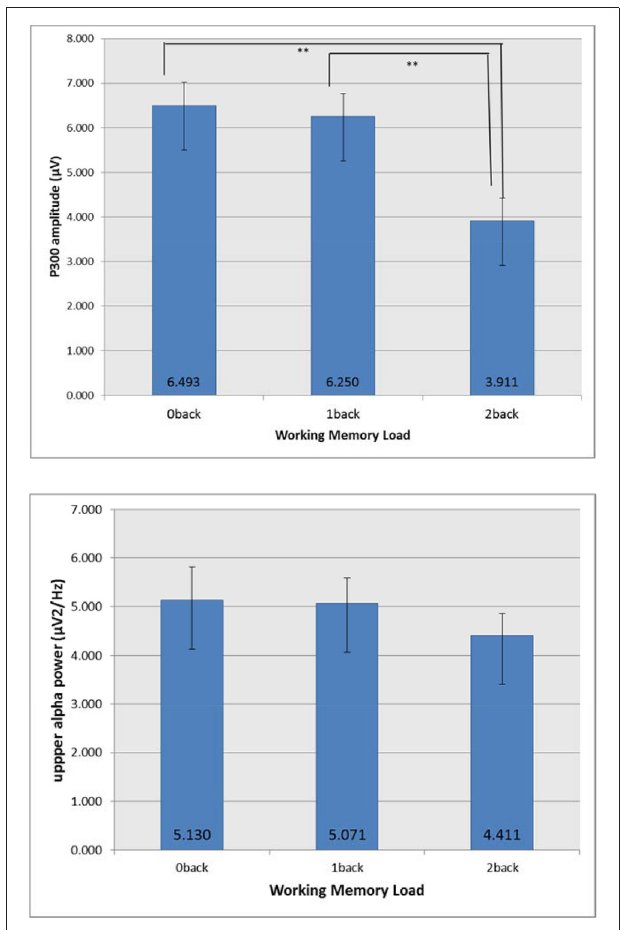
For 0-back level, ICA revealed 7 independent components. Their dipoles were source localized to following regions: right middle temporal gyrus (BA 21), right primary visual cortex (V1)